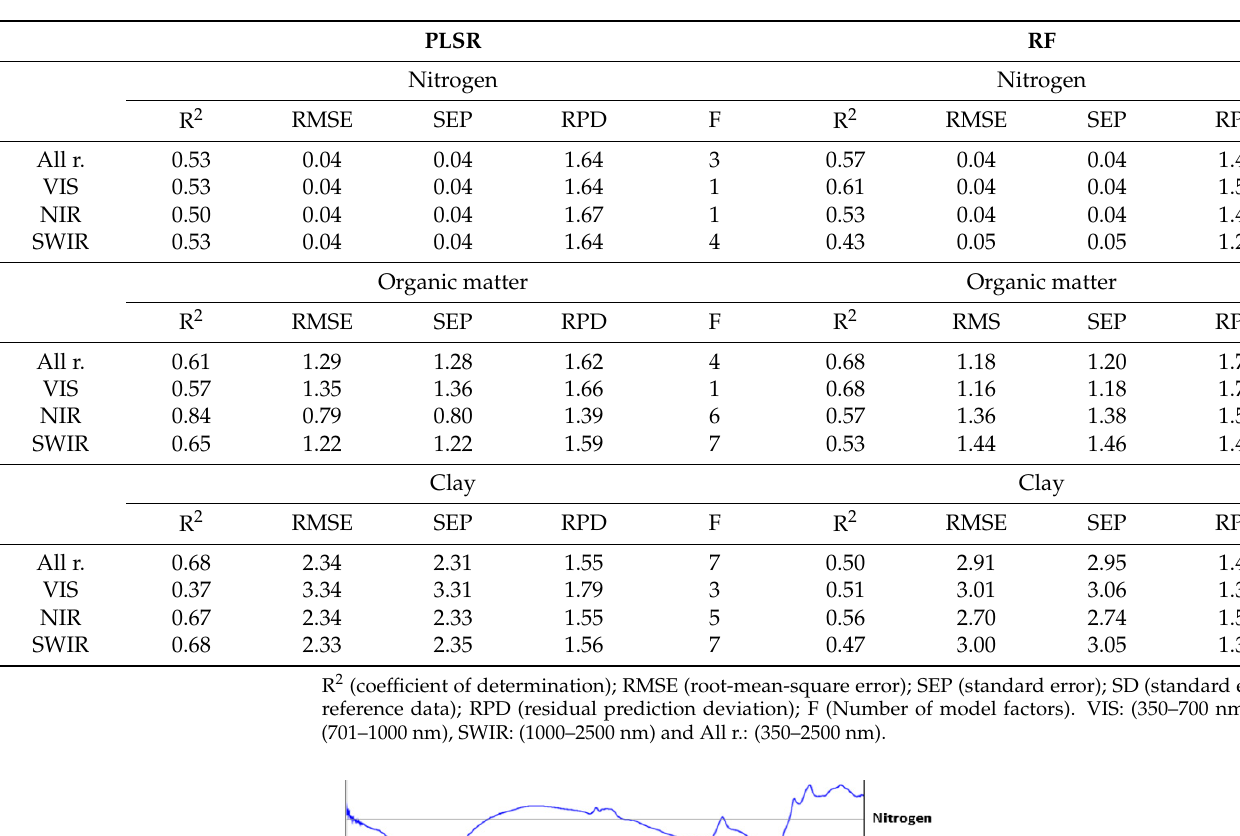
Table 3. Statistics of PLSR and RF regression models using the four spectral subsets as prediction variables. PLSR RF